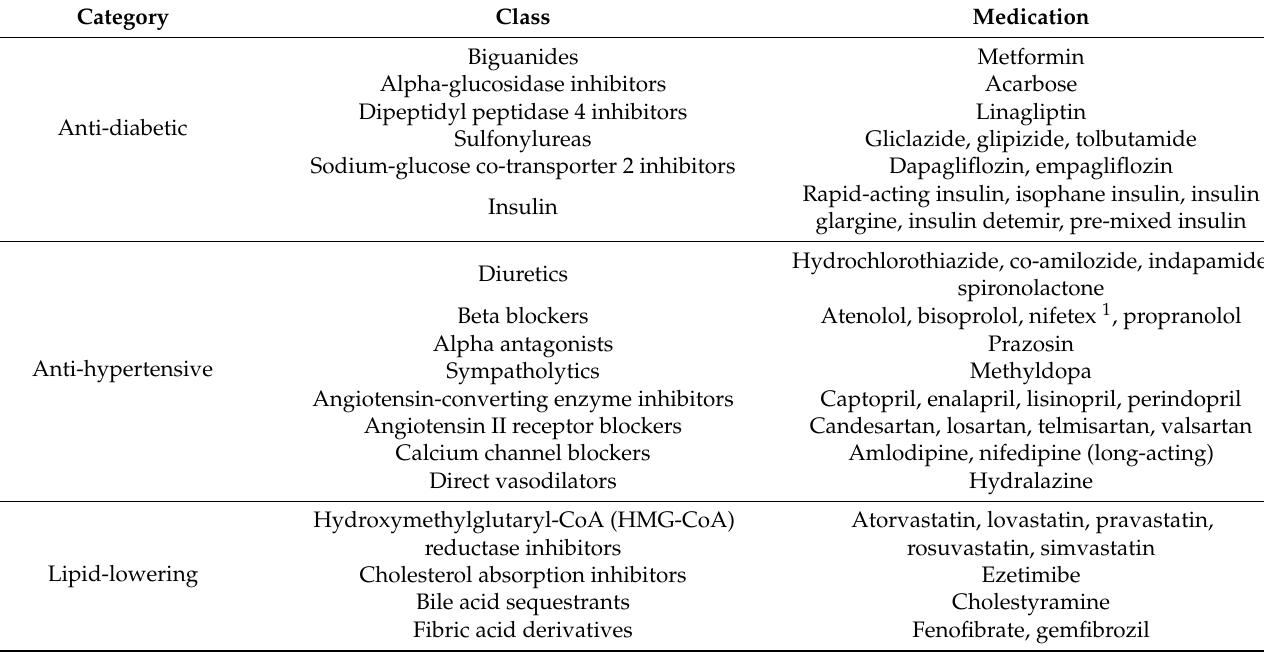
Table 2. List of categories and classes of medications in the dataset.